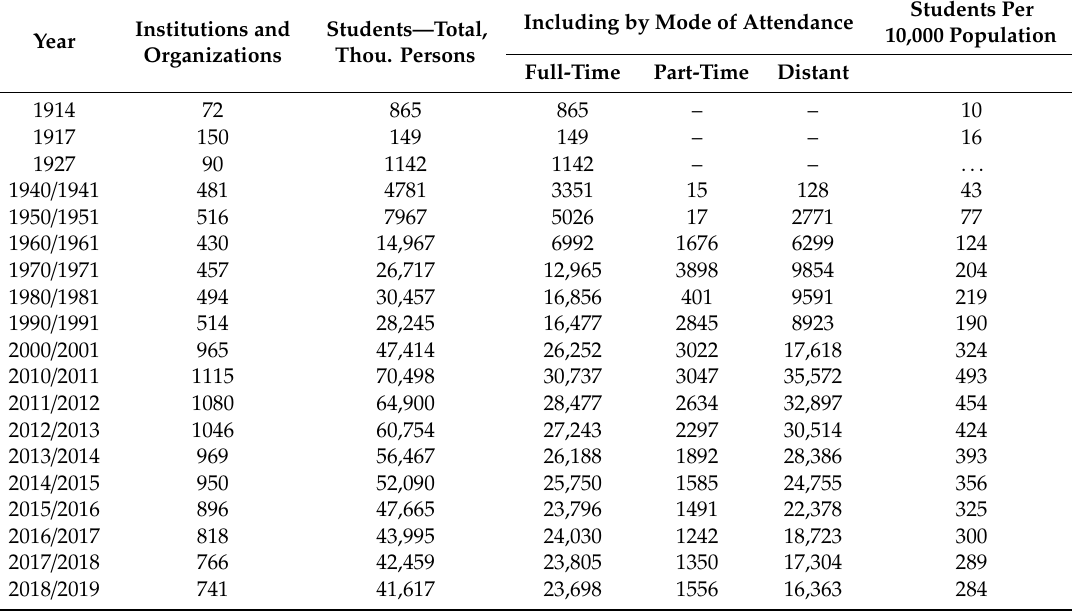
Table 1. Higher educational institutions and educational programs in the USSR and Russian Federation.